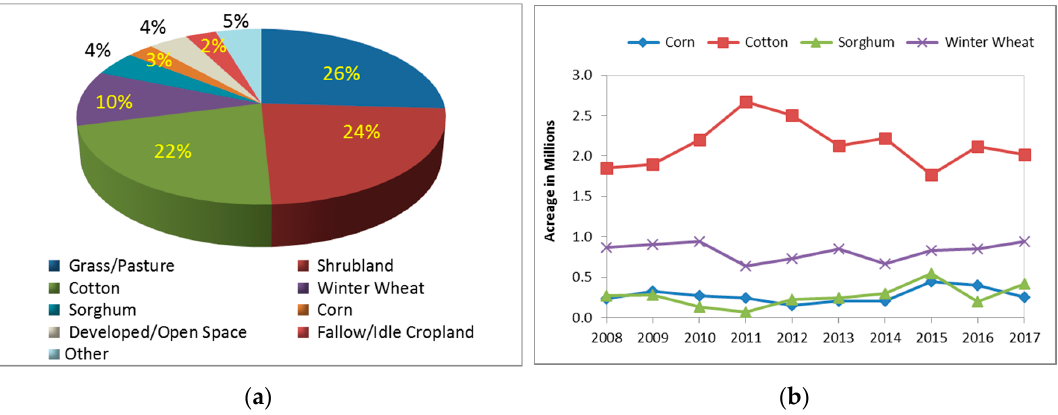
Figure 2. Major agricultural crops in Brazos Headwaters Basin. ( a ) Major land cover (2017). ( b ) Acreage of major croplands (2008–2017).